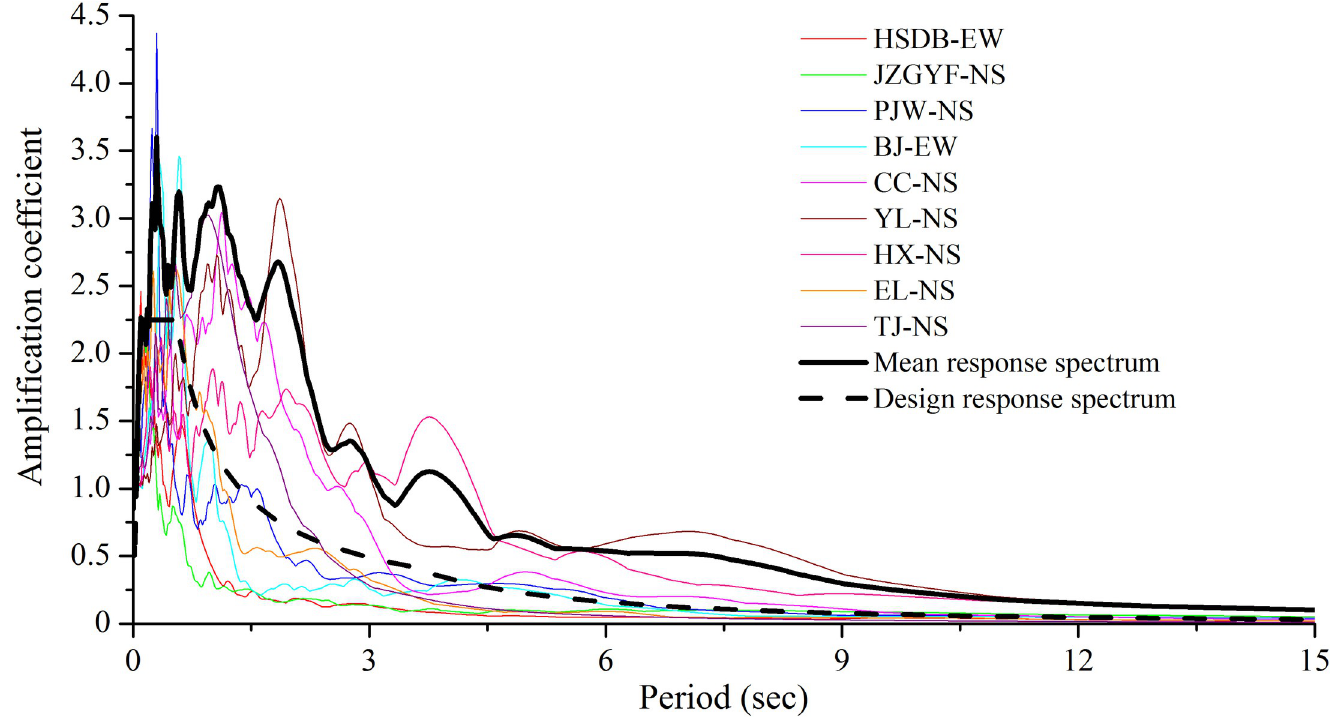
Fig 8. Response spectrums, mean response spectrum, and design response spectrum of earthquakes.